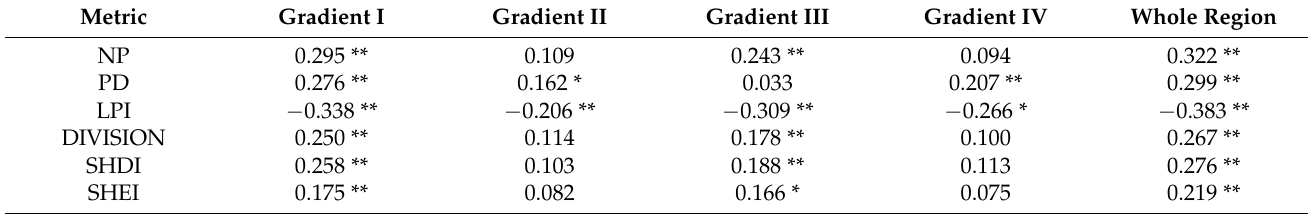
Table 11. Correlation coefficients between ecological risk change and landscape metrics variations from 2005 to